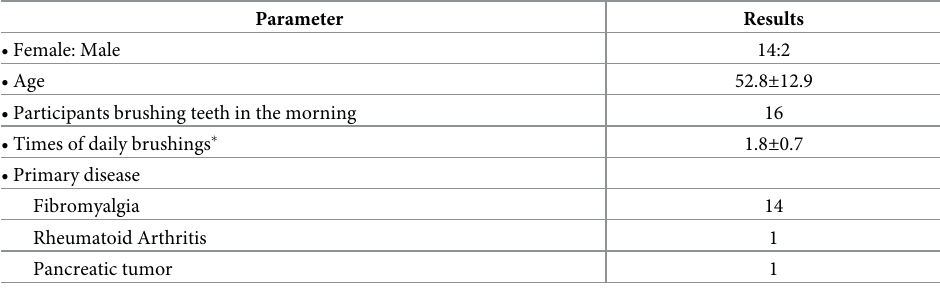
Table 1. Demographics and clinical parameters of all the